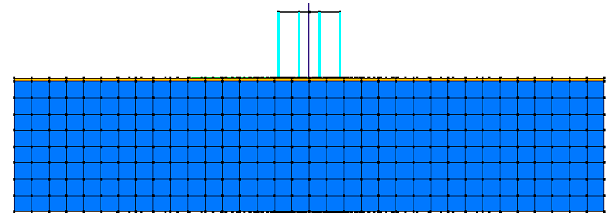
Figure 1. Three-dimensional mesh: soil (blue); geotechnical seismic isolation (GSI) liner (yellow).